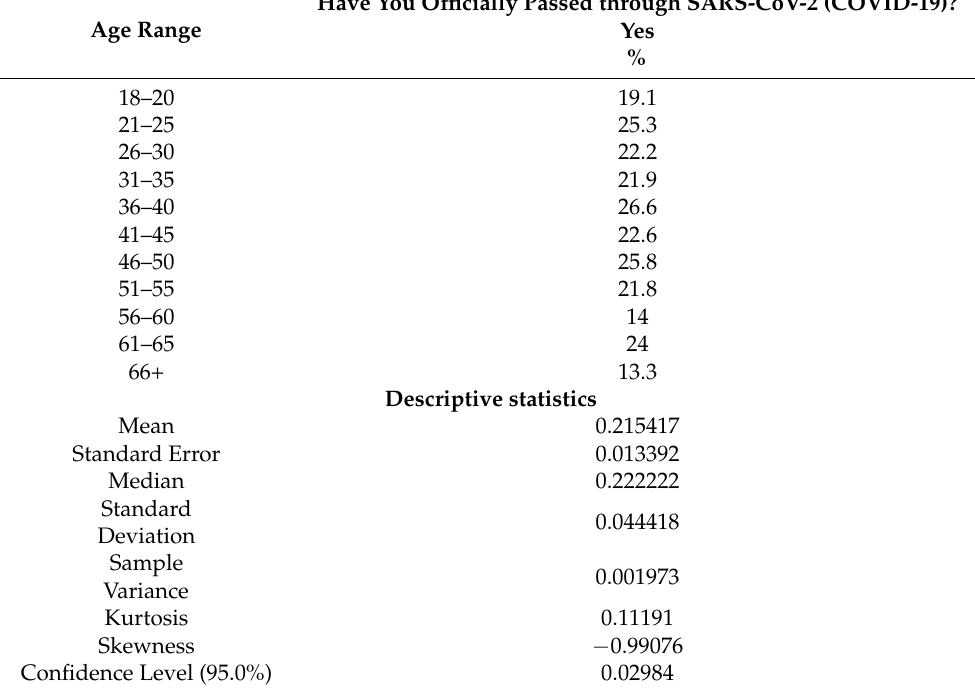
Table 5. SARS-CoV-2 infection frequency of